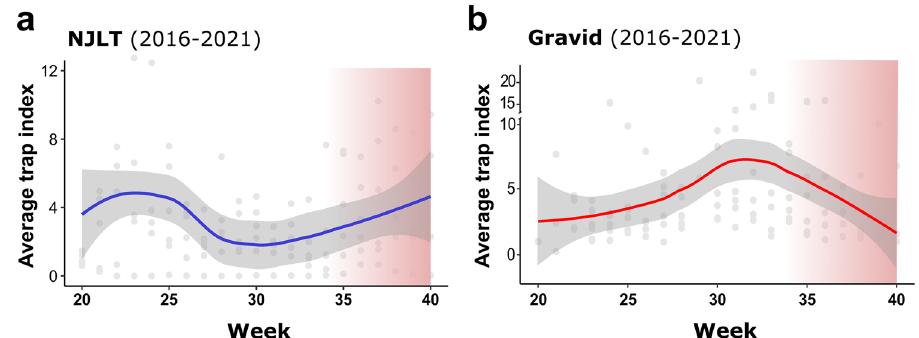
Fig. 3 Iowa mosquito surveillance data con fi rm the natural diapause timeline. Mosquito surveillance from central Iowa display mosquito populations trends that examine general population abundance ( a ) or represent only reproductive populations ( b ). Data in ( a ) represent Cx. pipiens group abundance measured using New Jersey Light Traps (NJLT) from 14 sites in central Iowa, while data in ( b ) display Gravid trap data from 16 sites in central Iowa that monitor reproductive female Cx. pipiens populations. For both a and b , collections were performed from 2016 – 2021 from weeks 20 to 40. Individual gray dots represent yearly trap index averages by week, with the blue (NJLT) or red (Gravid) lines representing the loess-smoothed mean and 95% con fi dence intervals (gray-shaded area). The approximate period of diapause receptivity (as de fi ned by our semi fi eld experiments) is displayed by the